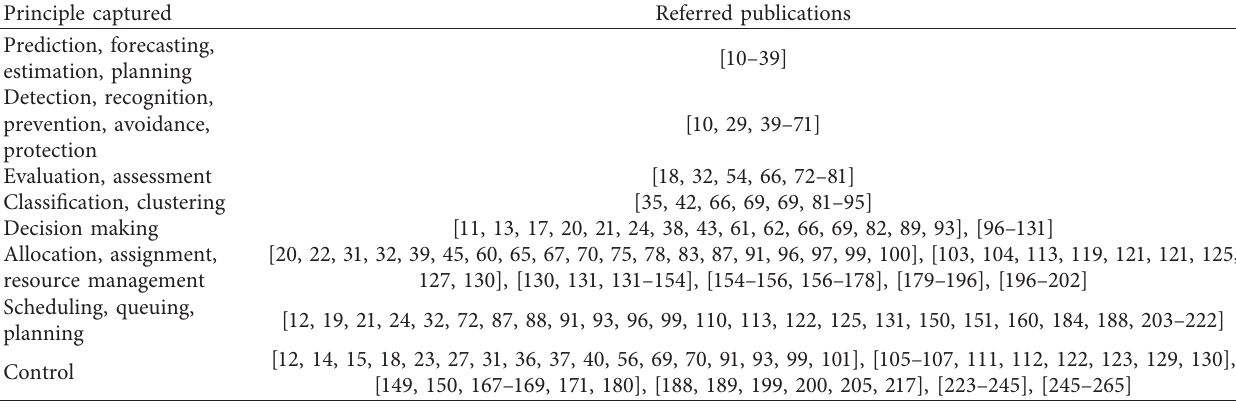
Table 1: Publication reference by principle captured.